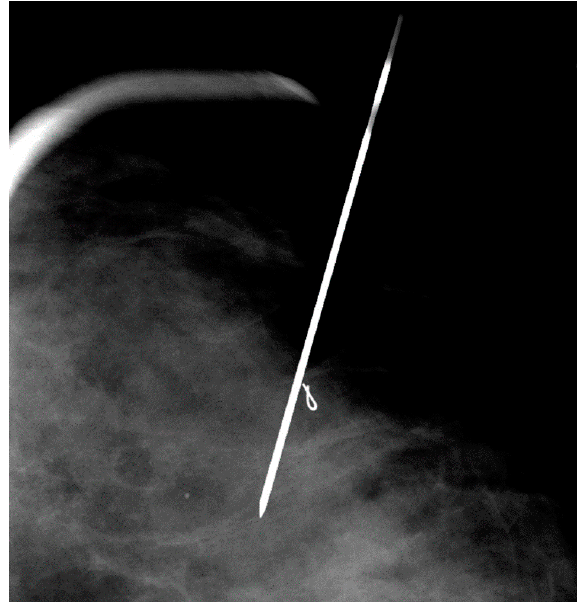
Figure 8. Mammographically-guided SLNB with one needle, targeting a clip marker.